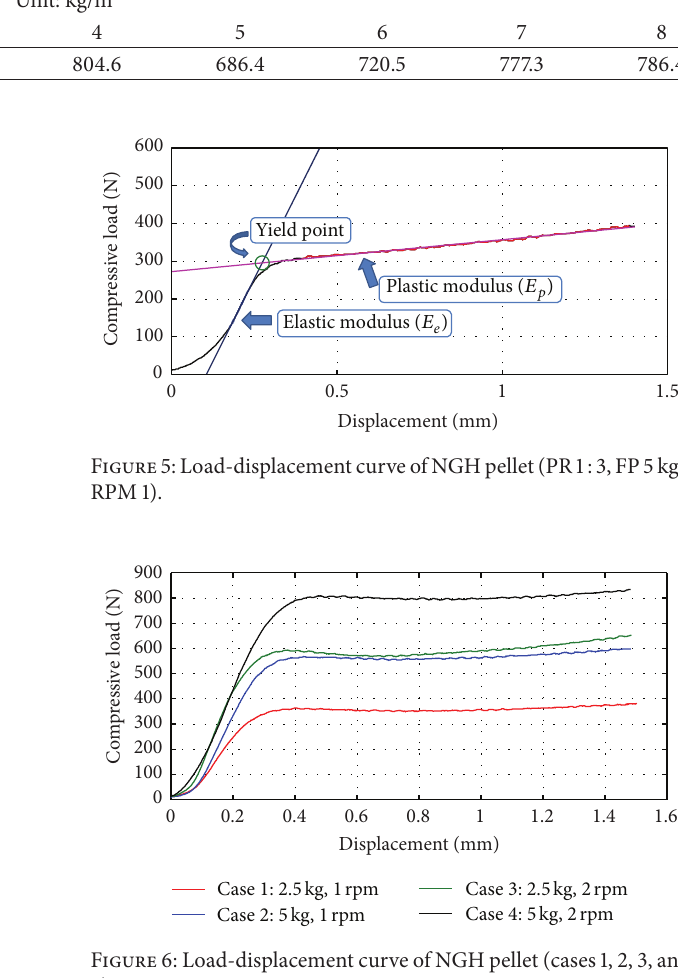
Figure 6: Load-displacement curve of NGH pellet (cases 1, 2, 3, and